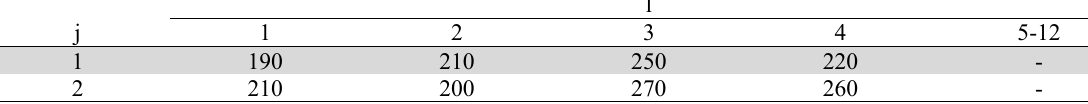
Distance between plants and retailers(d jl ) (km)